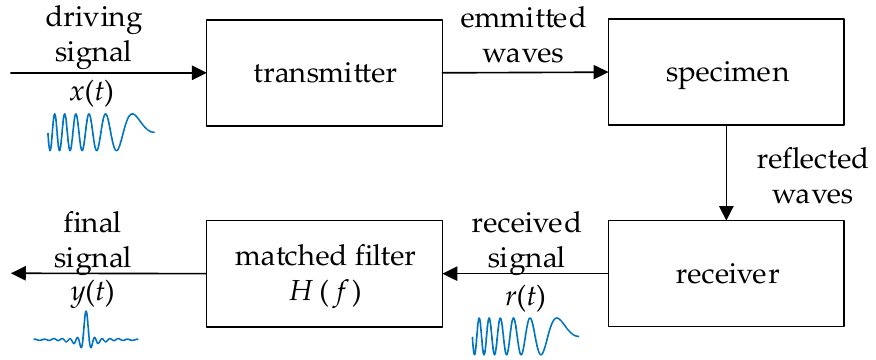
Figure 2. Schematic illustration of TPC process.